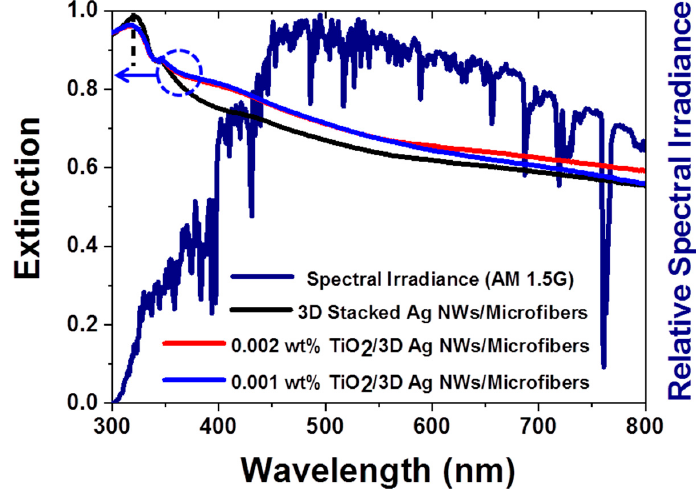
Figure 2. Extinction spectra of different nanomaterials and spectral irradiance of AM 1.5G. The composite nanostructures displayed high extinction in the visible range, in agreement with the solar spectrum in the visible range. The black lines indicate the interband transitions of Ag.